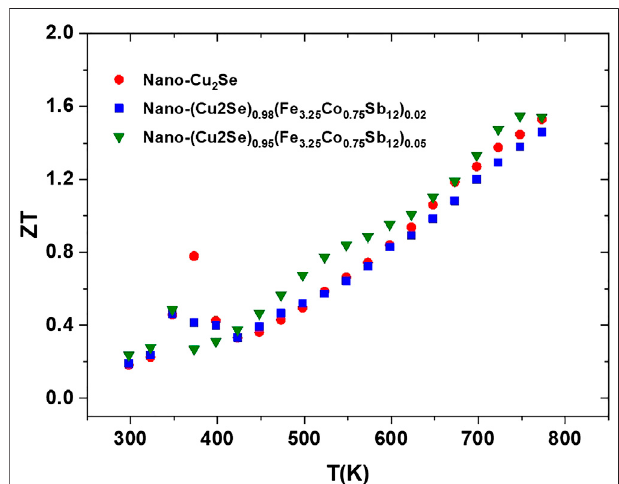
FIGURE 11 | The lattice thermal conductivity, κ nano-Cu